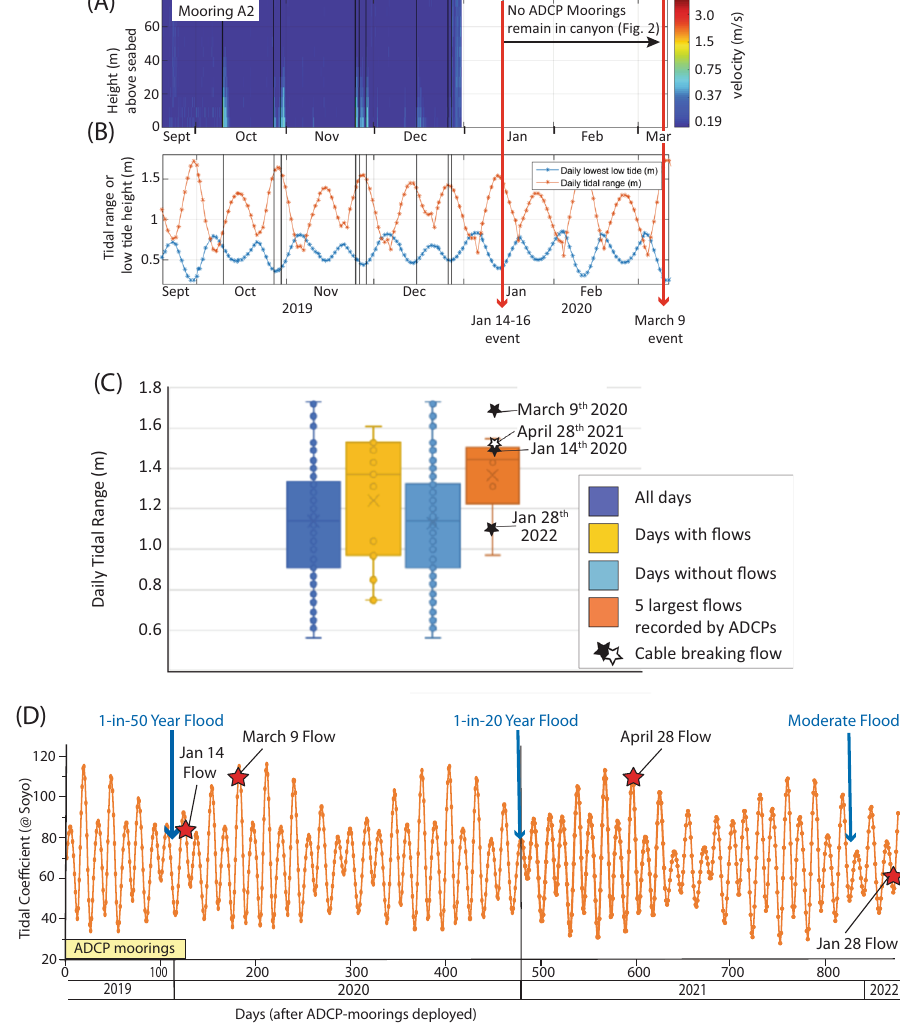
Fig. 4 Cable-breaking turbidity currents coincide with spring tides. A Time series of velocity pro fi les recorded by an ADCP at mooring site A2 in 2019 – 20 (Fig. 1), with warmer colours indicating turbidity currents. Superimpose are the arrival timings of long-runout, cable-breaking turbidity currents on January 14th and March 9th 2020 (red lines), and slower moving fl ows restricted to the upper canyon (thin black lines). B Time series of daily maximum tidal range, and daily lowest low tide, at Soyo in the estuary at the mouth of the Congo River. C Box and whisker plots showing median, fi rst and second quartiles of daily tidal range values for (i) all days in which ADCP-moorings were in the Congo Canyon in 2019 – 2020, (ii) days on which turbidity currents occurred at the ADCP moorings, (iii) days on which no turbidity currents occurred at ADCP moorings, and (iv) days on which the fi ve fastest non-cable-breaking fl ows occurred at ADCP moorings. Each box and whisker plot shows the median tidal range (x), tidal ranges on given days (o), and the 95% percentile of the distribution of tidal ranges for speci fi ed days (-). Stars indicate the maximum daily tidal range for the days on which the 4 cable-breaking fl ows showing times of three cable-breaking turbidity currents (red stars), and peak of major river fl oods (blue arrows). The larger the tidal coef fi cient, the greater the tidal range. Period in which ADCP-moorings deployed shown by yellow